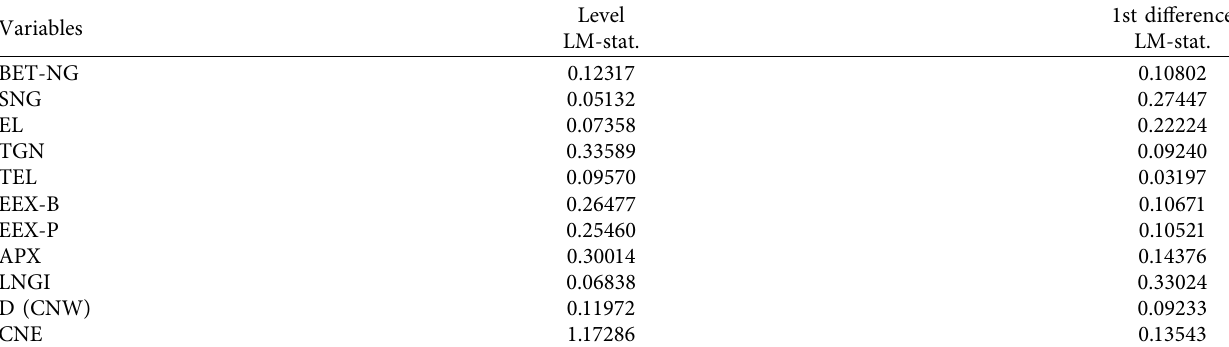
Table 5: The outcomes of the Kwiatkowski–Phillips–Schmidt–Shin unit root test.